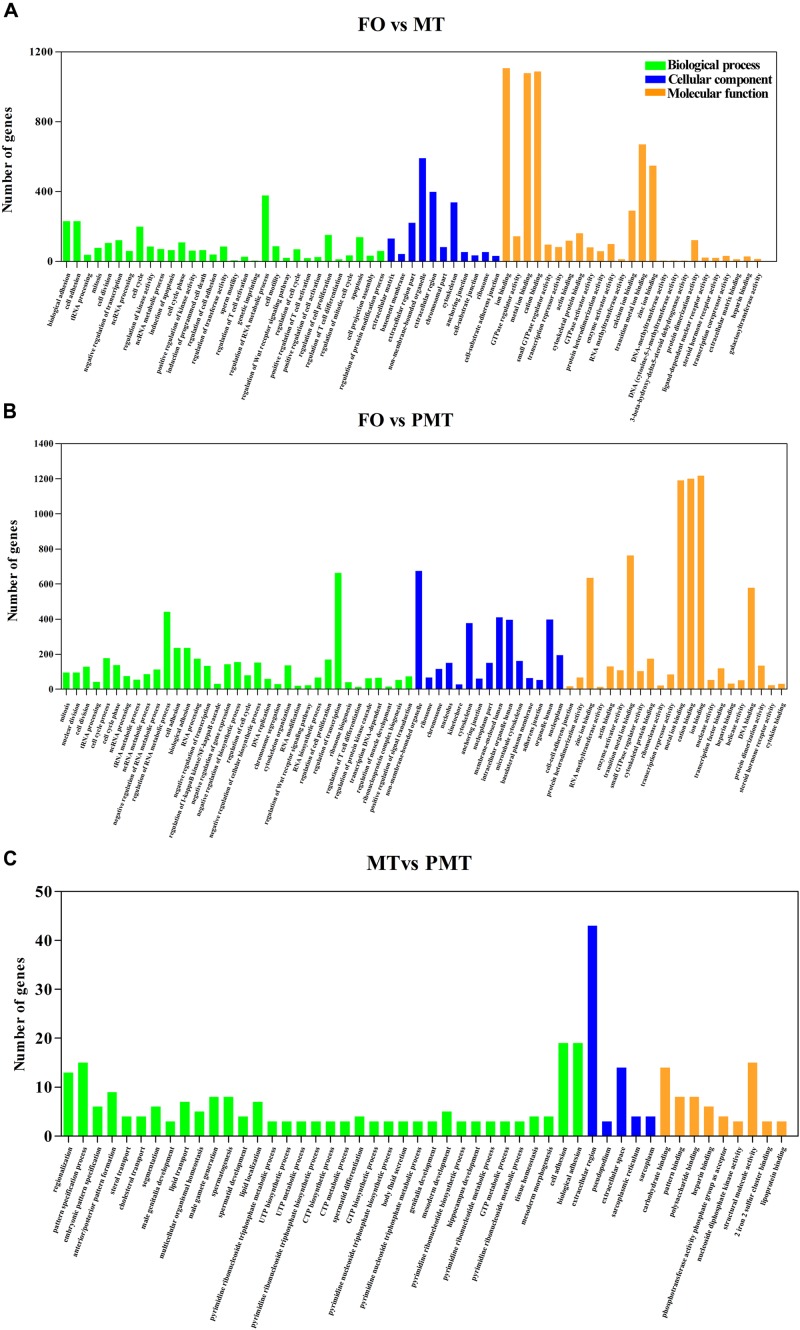
GO enrichment analysis of DEGs. DEGs were annotated to different GO terms in biological process, molecular function, and cellular component. (A) GO enrichment analysis of DEGs in FO vs MT. (B) GO enrichment analysis of DEGs in FO vs PMT. (C) GO enrichment analysis of DEGs in MT vs PMT.